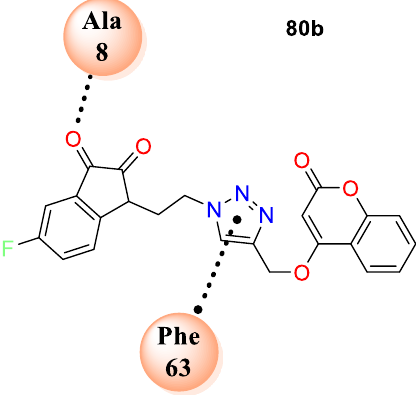
Figure 6. Docking conformation of 80b at the active site of DHFR.